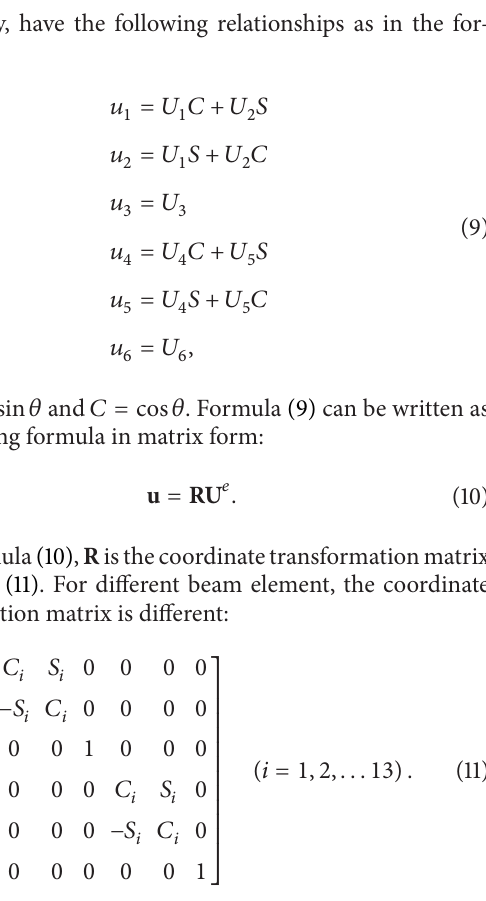
respectively, have the following relationships as in the for-